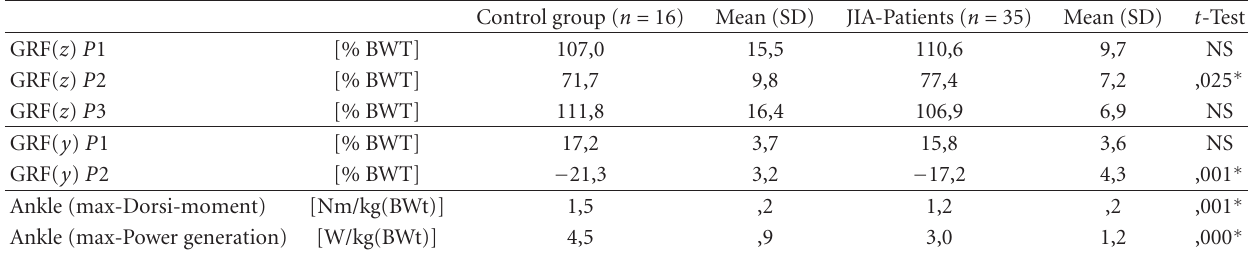
Table 3: Kinetic parameters of the Ground Reaction Force (GRF) in vertical plane ( z ) and horizontal in gait direction ( y ) as well as the ankle dorsal moment and power ( ∗ : statistically significant; NS: not